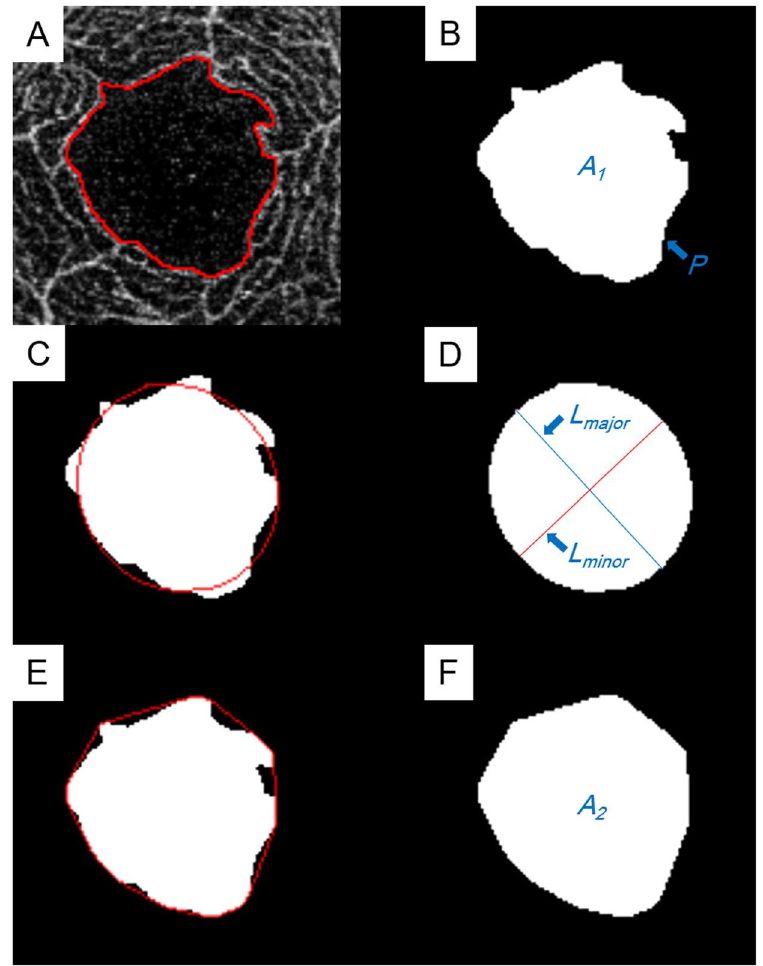
Figure 4. Parameters for assessing the foveal avascular zone (FAZ) obtained by optical coherence tomorgraphy angiography (OCTA). ( A ) The FAZ area was measured manually with the imageJ software. ( B ) Area ( A 1 ) and length of perimeter ( P ) was calculated automatically. Circularity was calculated as 4 π × A 1 / P 2 . ( C ) Ellipse was semi-automatically fitted to the FAZ by imageJ. ( D ) The major axis ( L major ) and minor axis ( L minor ) lengths were automatically calculated. The axial ratio was calculated as L major / L minor . Roundness was calculated as 4 π × A 1 /( L major ) 2 . ( E ) The convex hull was semi-automatically fit by imageJ. ( F ) Area of convex square( A 2 ) was automatically calculated. Solidity was calculated as A1 / A2